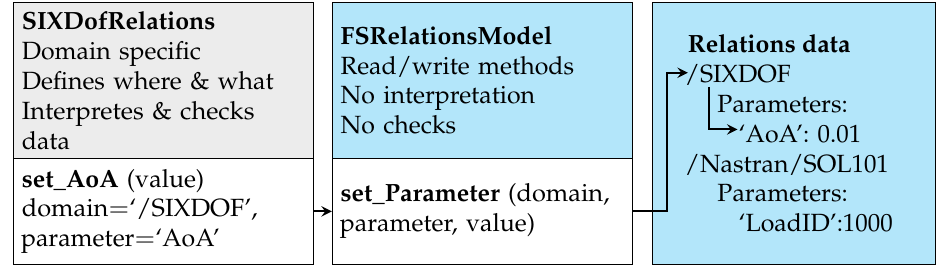
Figure 1. Components of the relations model used in UltraFLoads. TAURelations defines where and how the angle of attack is stored and provides methods to get/set the angle of attack